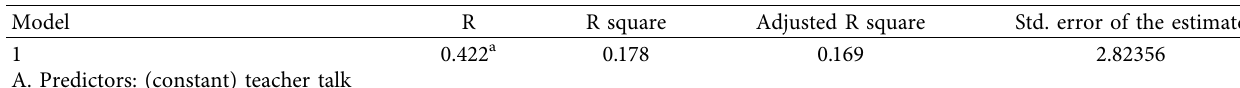
Table 2: Model summary.